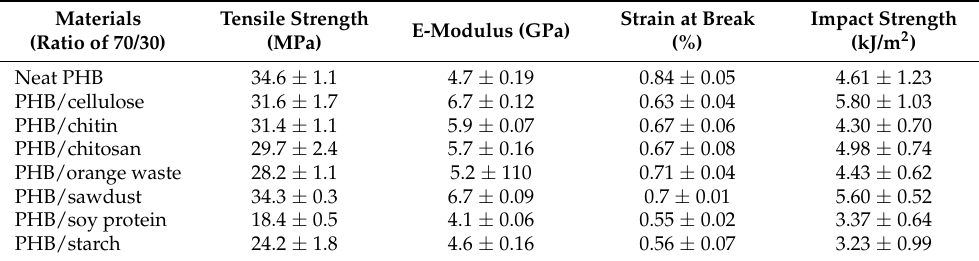
Table 2. Summary of the mechanical properties of neat PHB and its